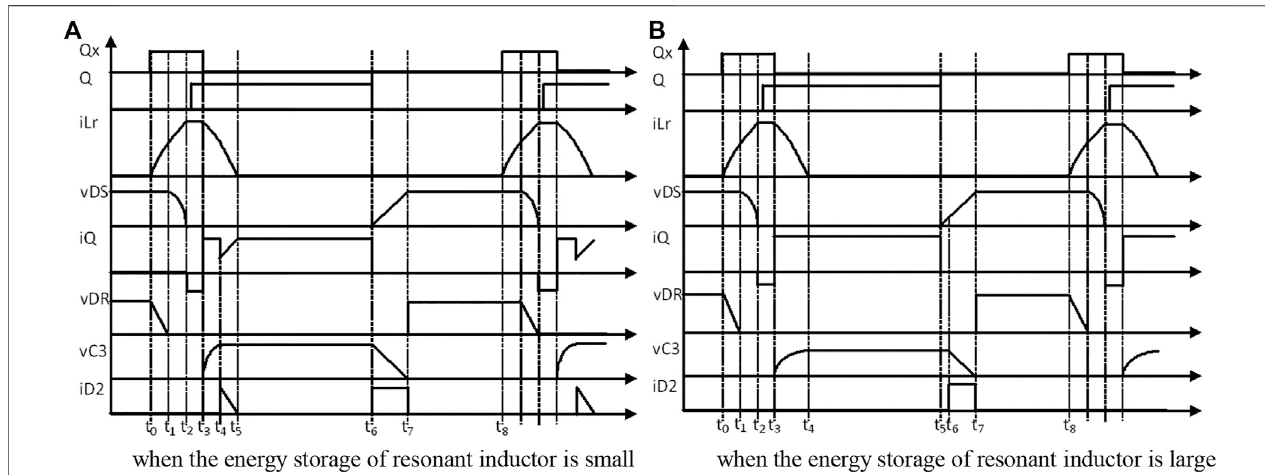
FIGURE 8 | Main power waveform diagram. (A) When the energy storage of the resonant inductor is small (C) When the energy storage of the resonant inductor is large.